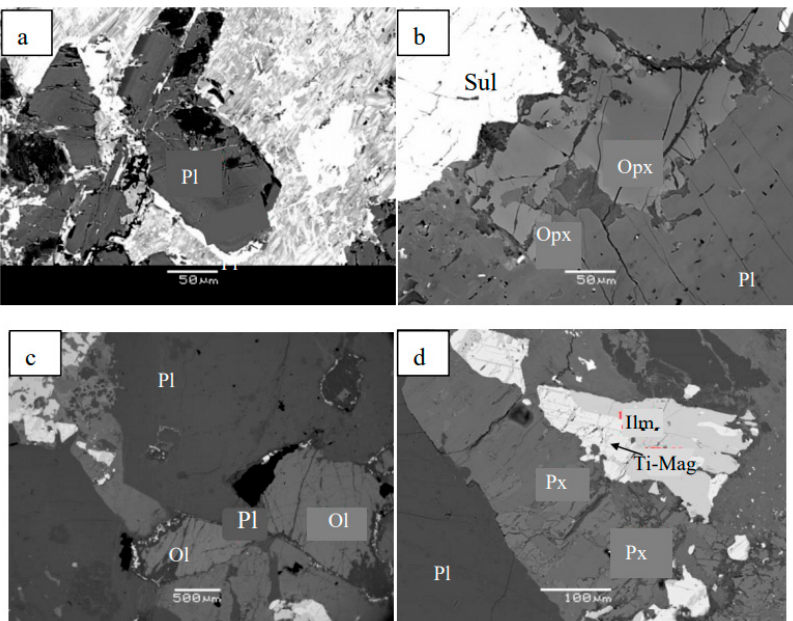
Figure 5. Backscattered electron (BSE) images of intrusive rocks from borehole RG-2: ( a ) contact gabbro-dolerites (depth 1885 m), ( b ) olivine gabbro-dolerite (1850 m), ( c ) troctolite (1803 m), ( d ) gabbro-dolerite (1772 m). Minerals: Pl: